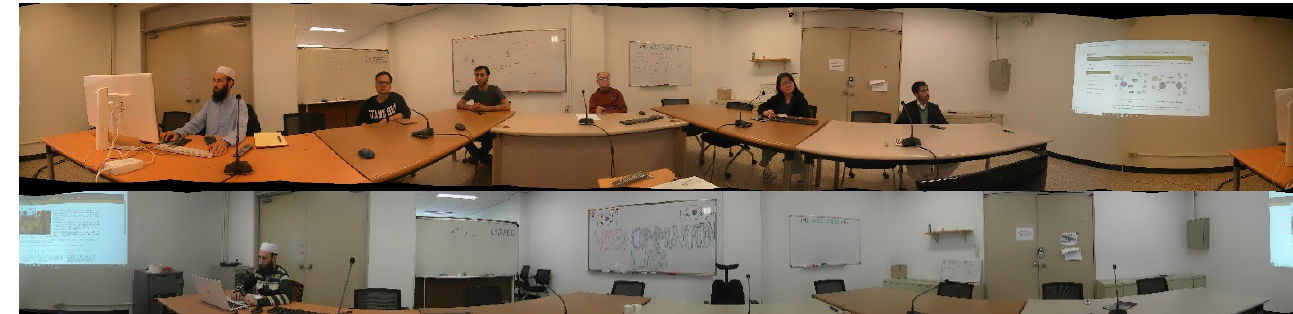
Figure 9. Panoramas from center: upper (10,400 × 1600 = 360° × 56°) and lower (10,400 × 1000 = 360° × 36°).